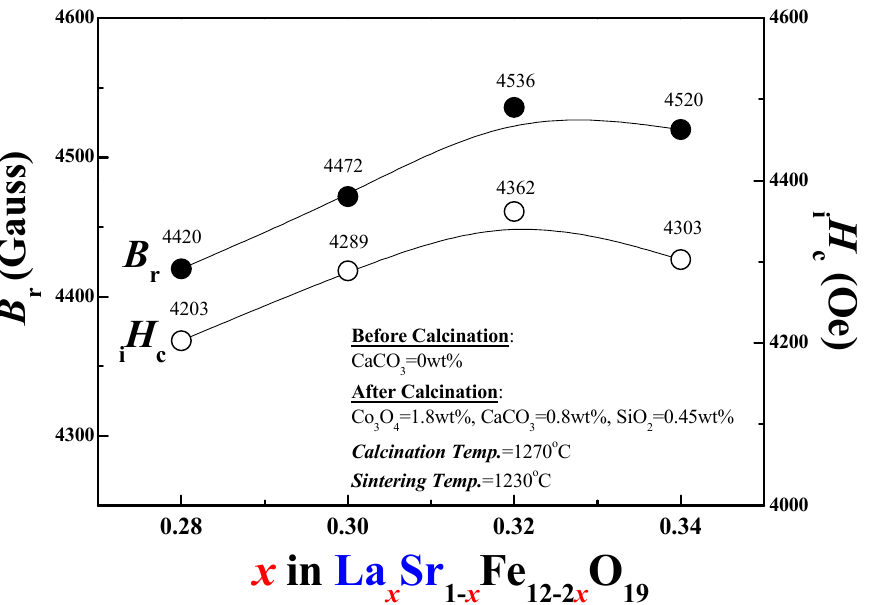
Figure 1. Dependence of B r and i H c of the fabricated sintered magnet on the x value of the formula La x Sr 1- x Fe 12-2 x O 19 calcined ferrite.